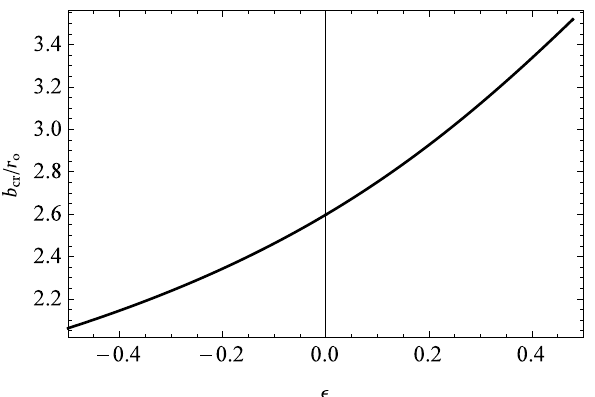
Figure 2. Dependence of the critical impact parameter of photon on the parameter (cid:101) . Here a junction with the vertical line at (cid:101) = 0 corresponds to the one in general